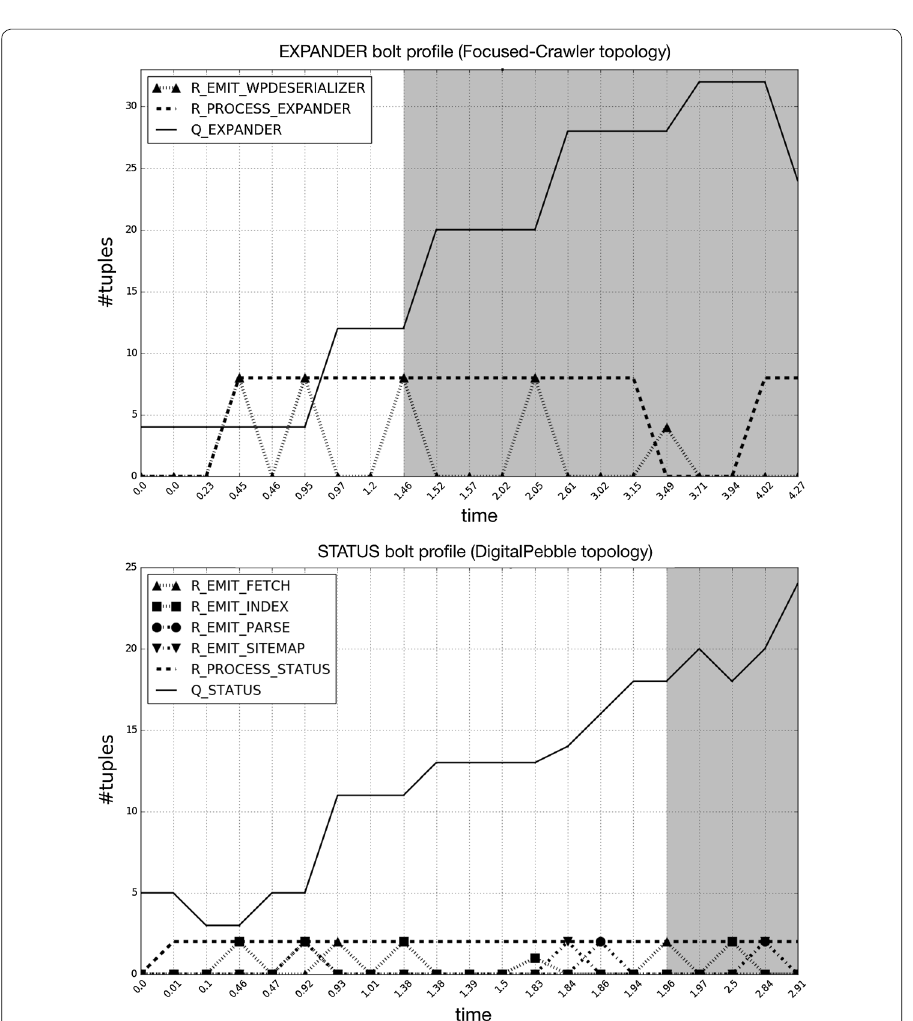
Fig. 12 OSTIA-based formal verification output traces showing the evolution of the two bolts over time. Queue trends are displayed as solid black line. Dashed lines show the processing activity of the bolts, while the other lines illustrate the incoming tuples from the subscribed nodes ( emit